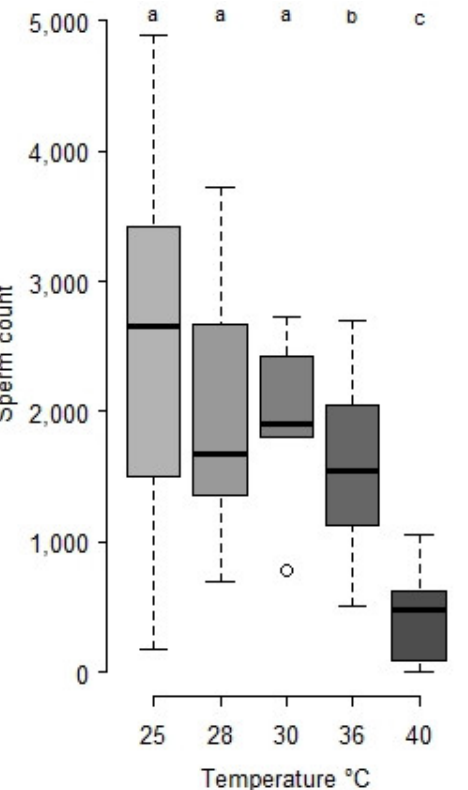
Figure 3. Sperm stock in seminal vesicles of M. rufiventris 1-day old virgin males developed at 25 °C after a 24 h heat period at the white pupal stage. The number of males is in the text. Kruskal–Wallis test, Chi² = 30.1, df = 4, p < 0.001. Letters indicate statistical differences from the 25 °C control (Wilcoxon test, a for p > 0.1, b for p < 0.05, c for p < 0.001).